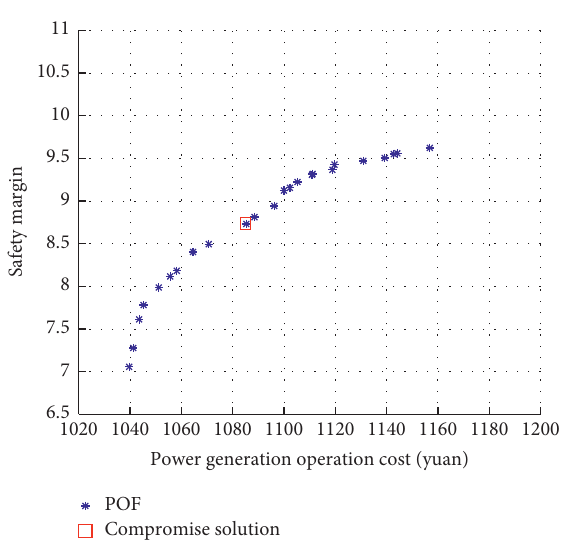
Figure 5: POF from initial failure L